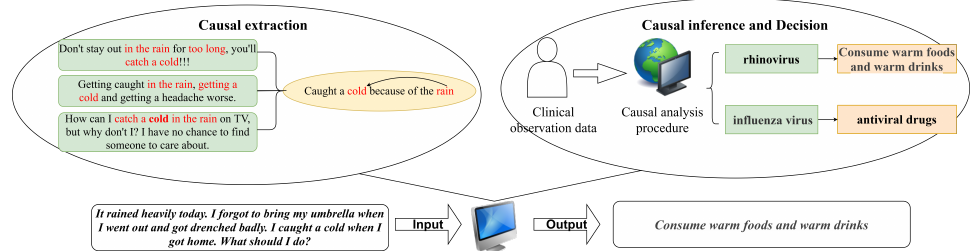
Figure 1. Application of causality extraction in decision-making and question answering.